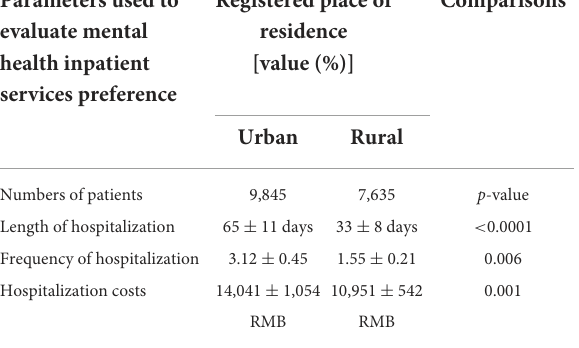
TABLE 7 Mental health inpatient services preference disparities in the utilization according to a registered place of residence. Parameters used to